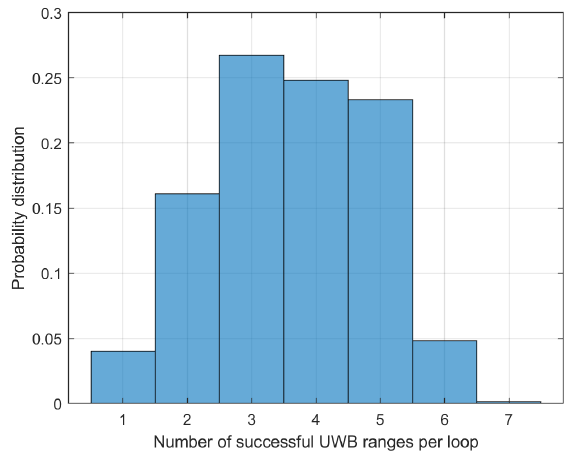
Figure 5. Distribution of the number of successful UWB ranges per measurement loop.